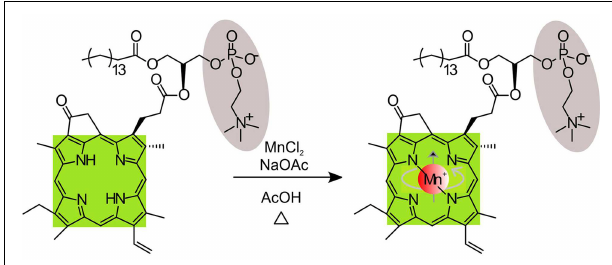
FIGURE 7 | Schematic showing the post chelation process of Mn ion into the pyro-lipid. (Adapted with permission from MacDonald et al.